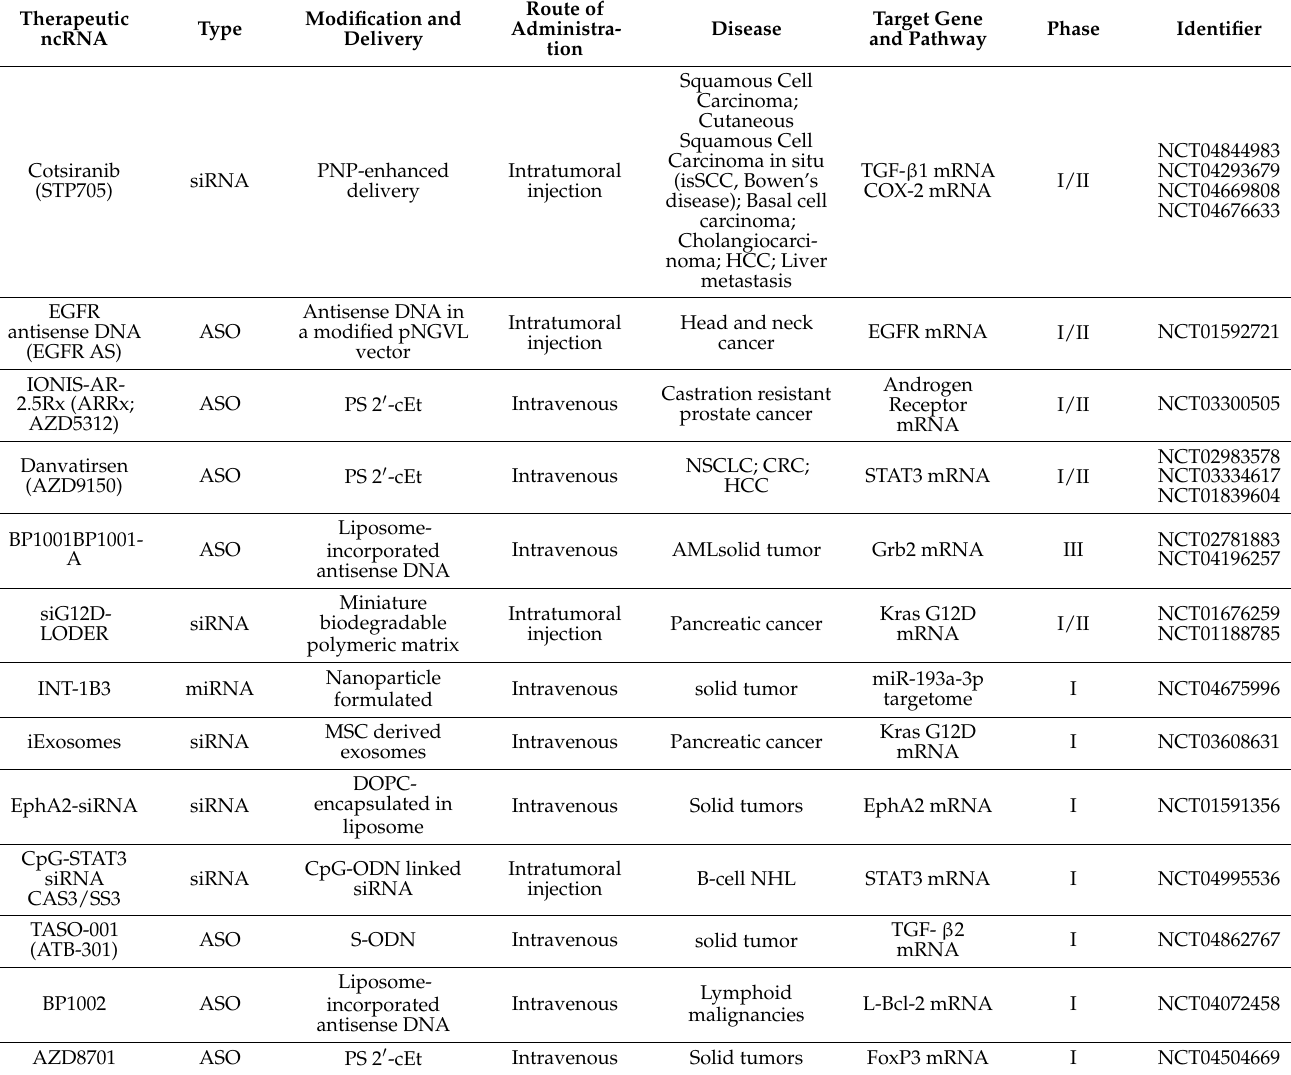
Table 2. Examples of ncRNA therapeutics for cancer currently in clinical